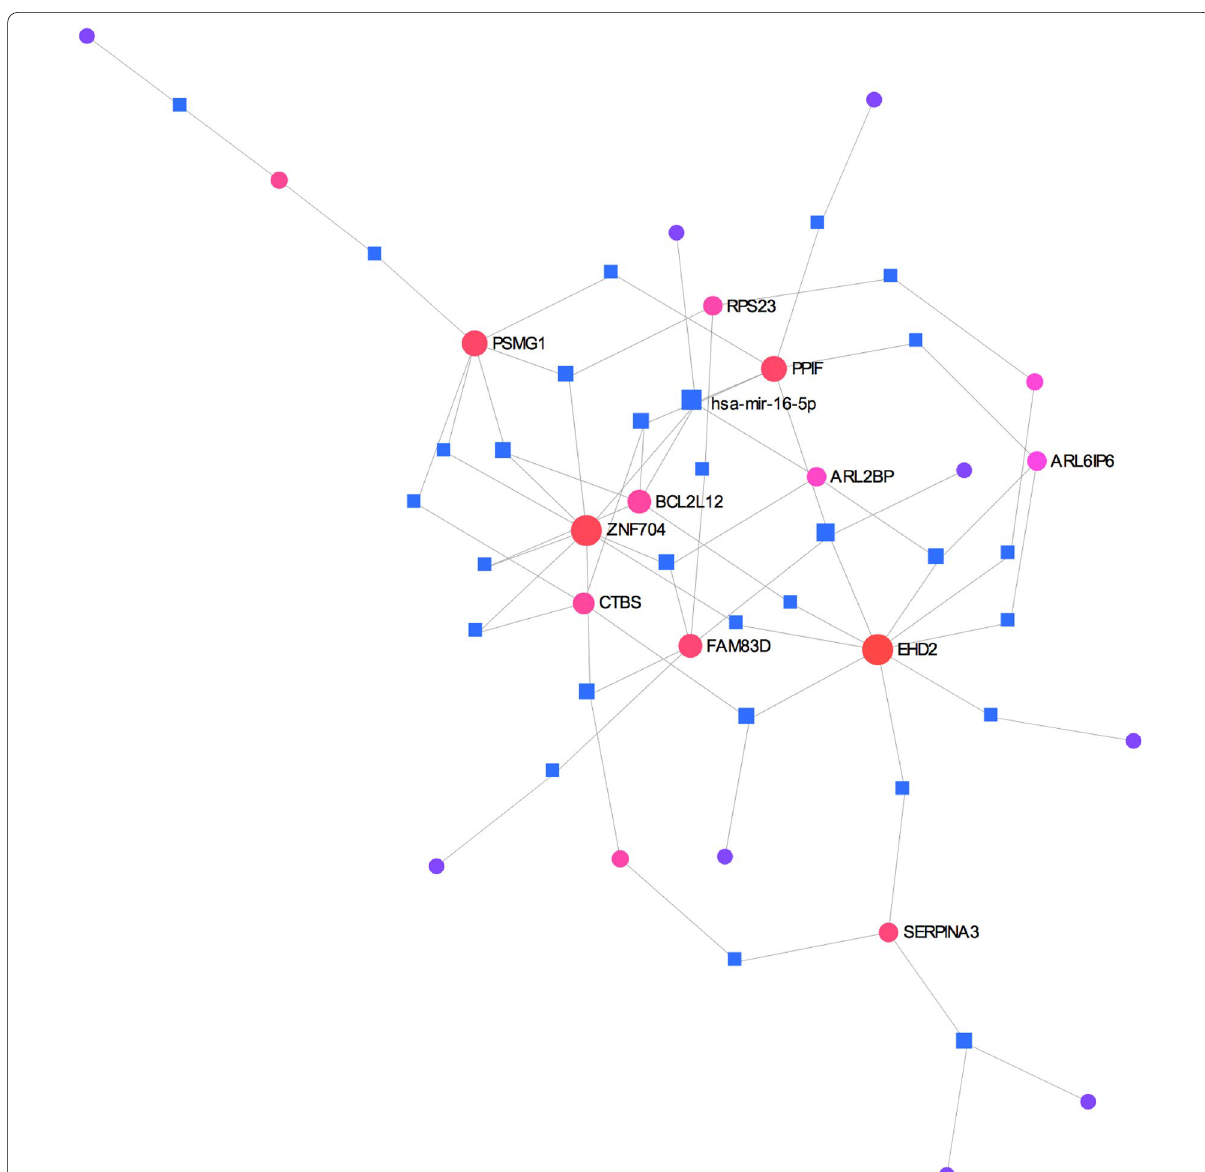
Fig. 3 miRNA-gene network analysis for identified significant DEGs. The identified DEGs are illustrated by circles and associated mi-RNAs are presented by